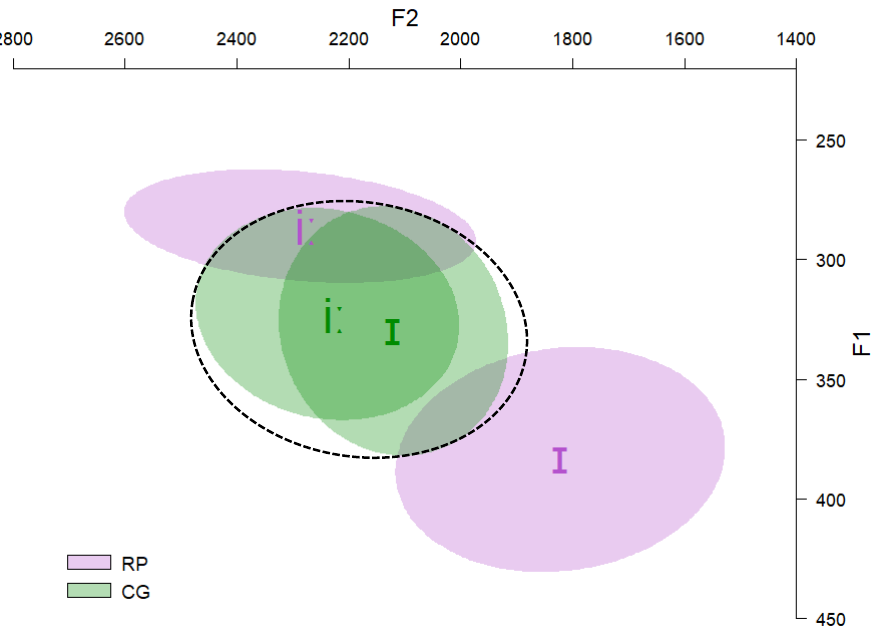
Figure 3. F1 × F2 of English / ɪ / and /i ː / as produced by CG and RP speakers.